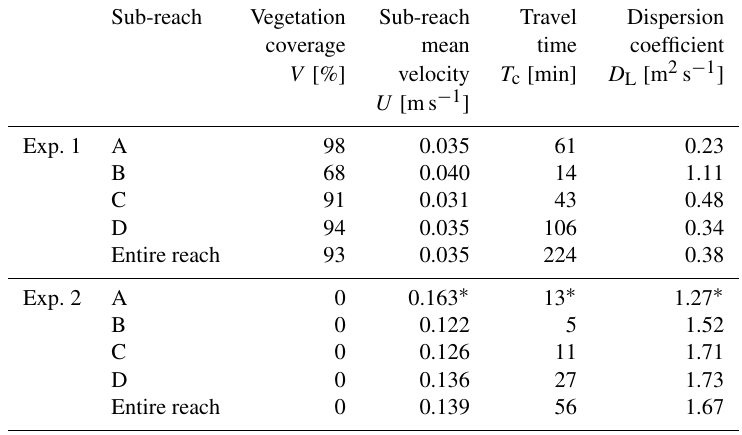
Table 3. Vegetation coverage and parameters describing flow and mixing based on the tracer data for four sub-reaches and the entire analysed reach of the channel during the experiments with (Exp. 1) and without (Exp. 2) vegetation.